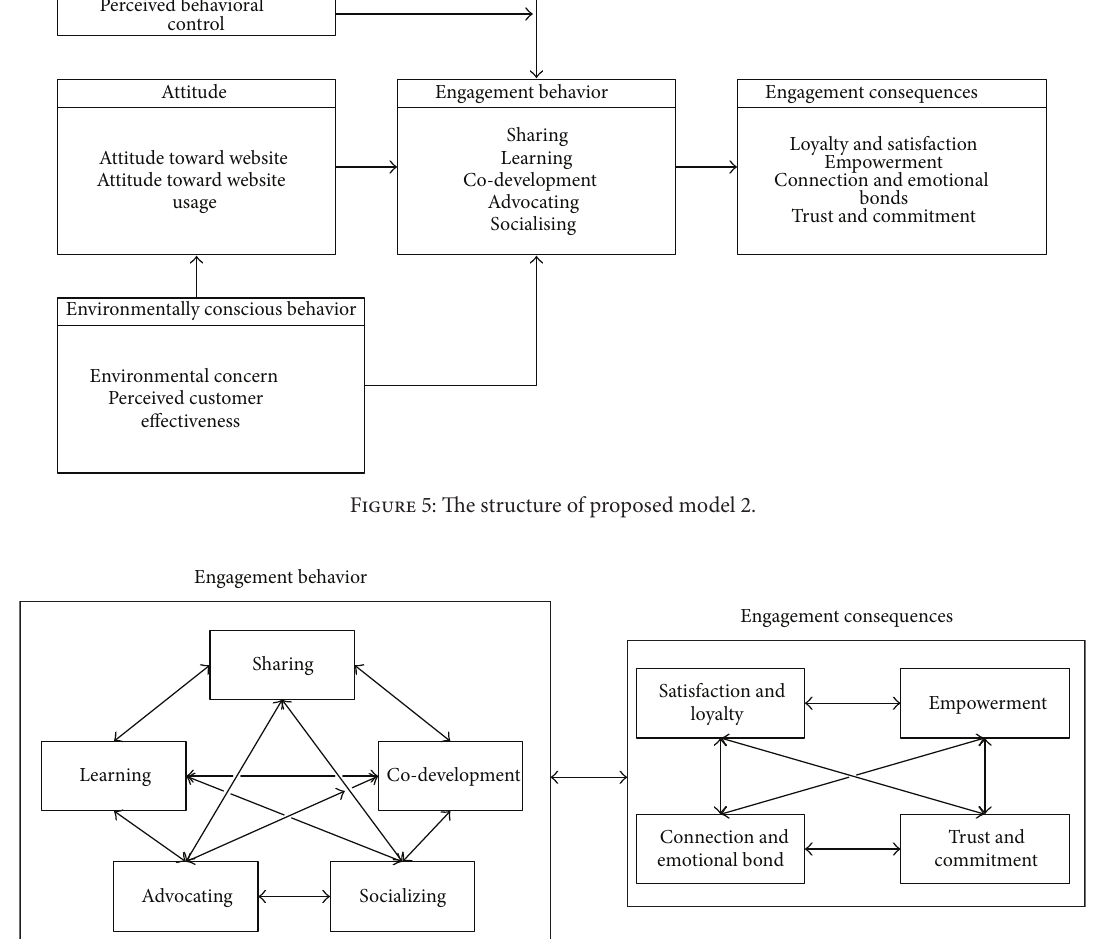
Figure 6: The structure of proposed model 3.